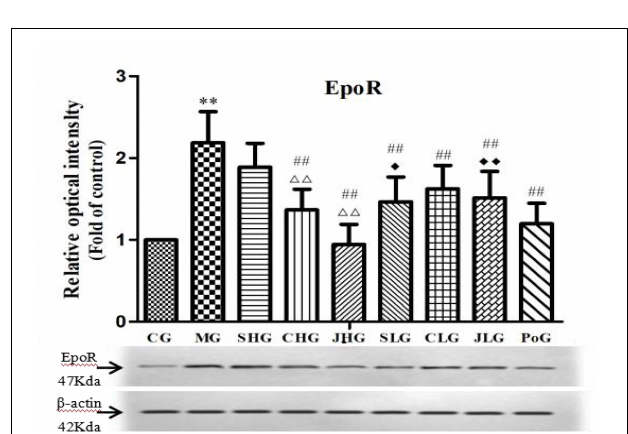
FIGURE 4 | Observation for EpoR protein expression in hepar. CG, control group, MG, model group, SHG, Curcumae Longae Radix group, CHG, Stir-frying Curcumae Longae Radix with vinegar group, JHG, Stir-frying Curcumae Longae Radix with wine group, SLG, Curcuma phaeocaulis Radix group, CLG, Stir-frying Curcuma phaeocaulis Radix with vinegar group, JLG, Stir-frying Curcuma phaeocaulis Radix with wine group and PoG, positive group. Values were mean ± SD ( n = 6). ∗ p < 0.05 and ∗∗ p < 0.01 vs. control group # p < 0.05 and ## p < 0.01 vs. model group (cid:49) p < 0.05 and (cid:49)(cid:49) P <